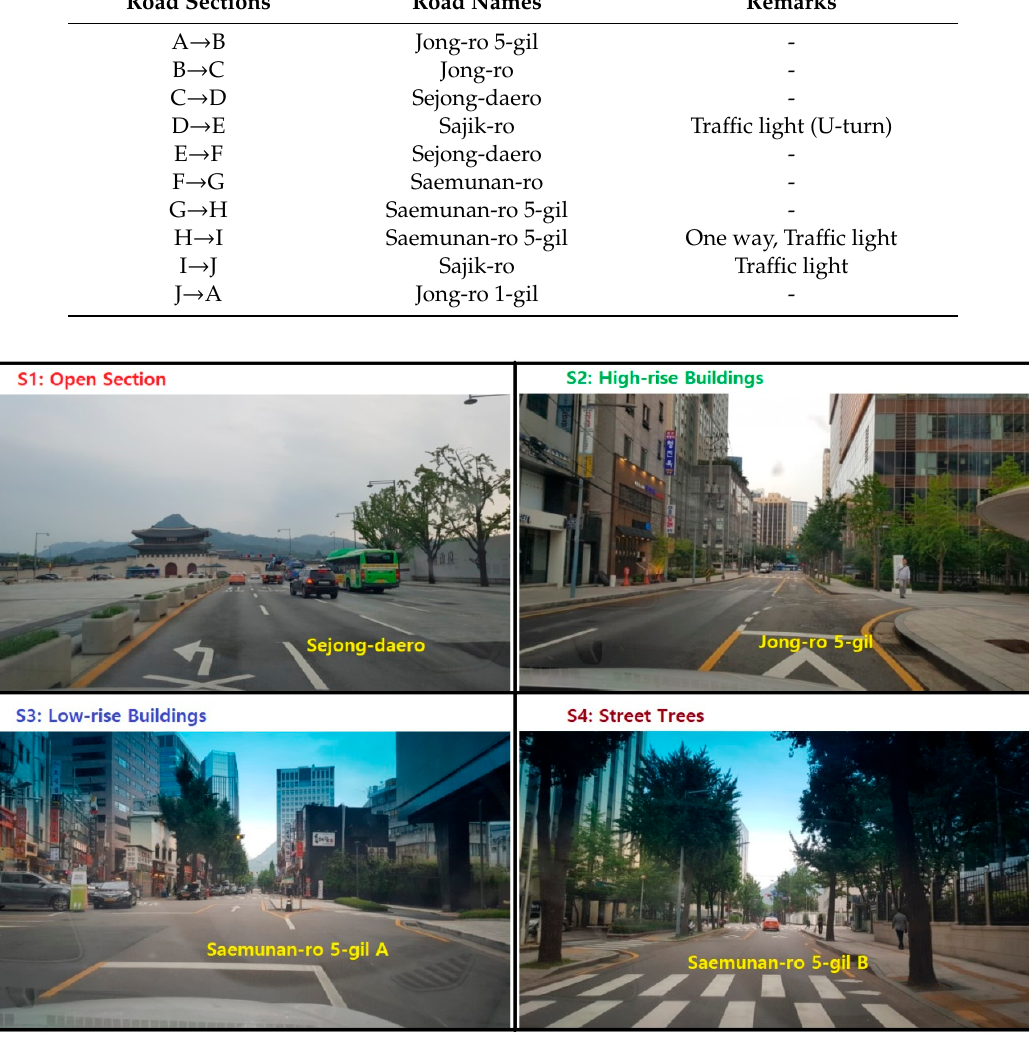
Figure 2. Four urban streets around Gwanghwamun, Seoul. Each road corresponds to the closed circle with separated color marked in Figure 1.